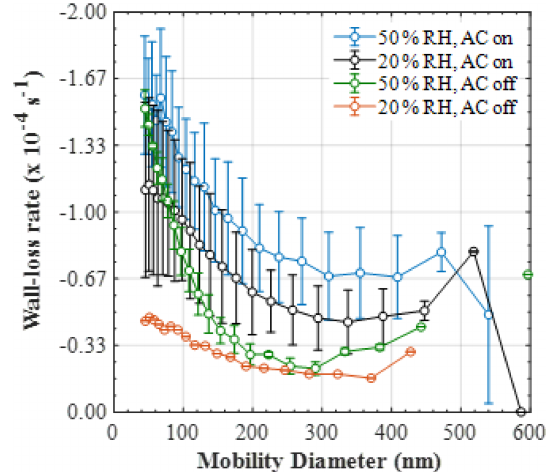
Figure 5. Mean ( ± 1 σ ) size-resolved wall loss rate (s − 1 ) of particles in the MAC at various relative humidities and mixing conditions (50% RH and mixing, n = 9; 20% RH and mixing, n = 5; 50% RH and no mixing, n = 3; 20% RH and no mixing, n =